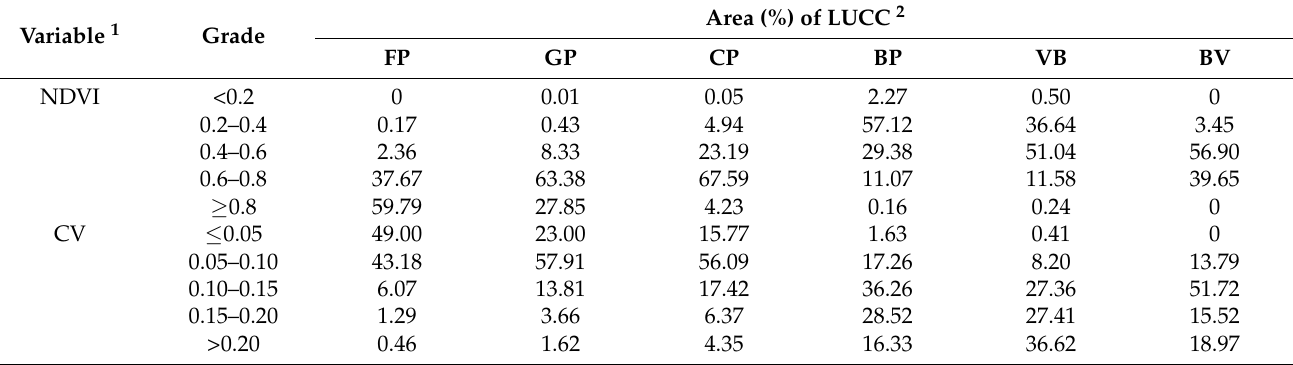
Table 2. Area statistics of NDVI and CV for main LUCC